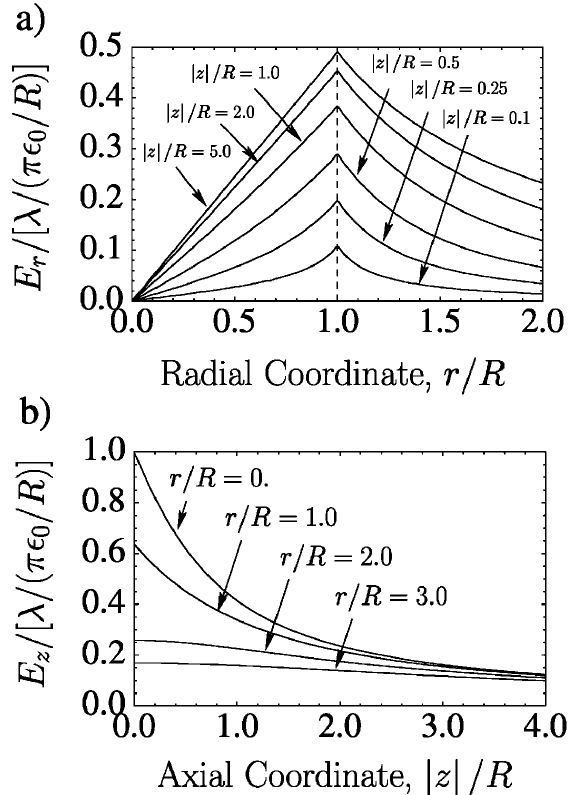
FIG. 3. Radial and axial electric self-field components [Eq. (12)] of a uniform density axisymmetric beam with radius R (cid:1) const near a conducting plate. In (a) the scaled radial = (cid:12) (cid:23)= (cid:3) (cid:24)(cid:18) R (cid:4)(cid:13) is plotted versus r=R in fixed z electric field E r 0 = (cid:12) (cid:23)= (cid:3) (cid:24)(cid:18) R (cid:4)(cid:13) is planes. In (b) the scaled axial electric field E z 0 plotted versus j z j =R in fixed r